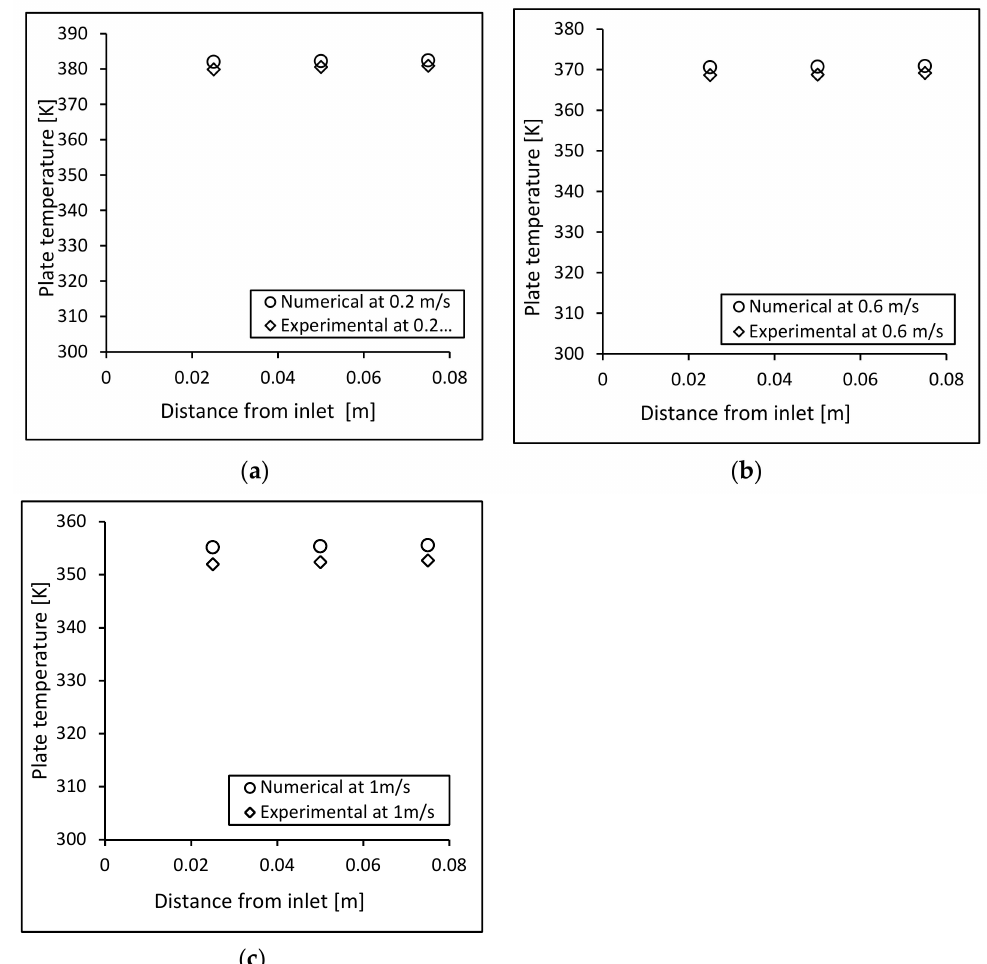
Figure 12. Comparison between experimental and numerical results for end plate 1: Temperature along plate length for flow velocity: ( a ) 0.2 m/s; ( b ) 0.6 m/s; ( c ) 1.0 m/s. A useful comparison from a practical point of view is between internal and external plate temperatures. Such a comparison is shown in Figure 13; part (a) is for the low air velocity of 0.2 m/s, while part (b) is for 1.5 m/s. For the low velocity of 0.2 m/s, the internal and external plates have practically identical temperatures at the three locations along the flow direction. The temperature increases in the flow direction, as the air absorbs heat from the heated plates. For the high velocity of 1.5 m/s, the internal and external plate temperatures are close to each other, but there is a noticeable difference between them, as shown in part b of Figure 13. The internal plate temperature is slightly higher. This means that no special design is needed for an external cell in terms of cooling.